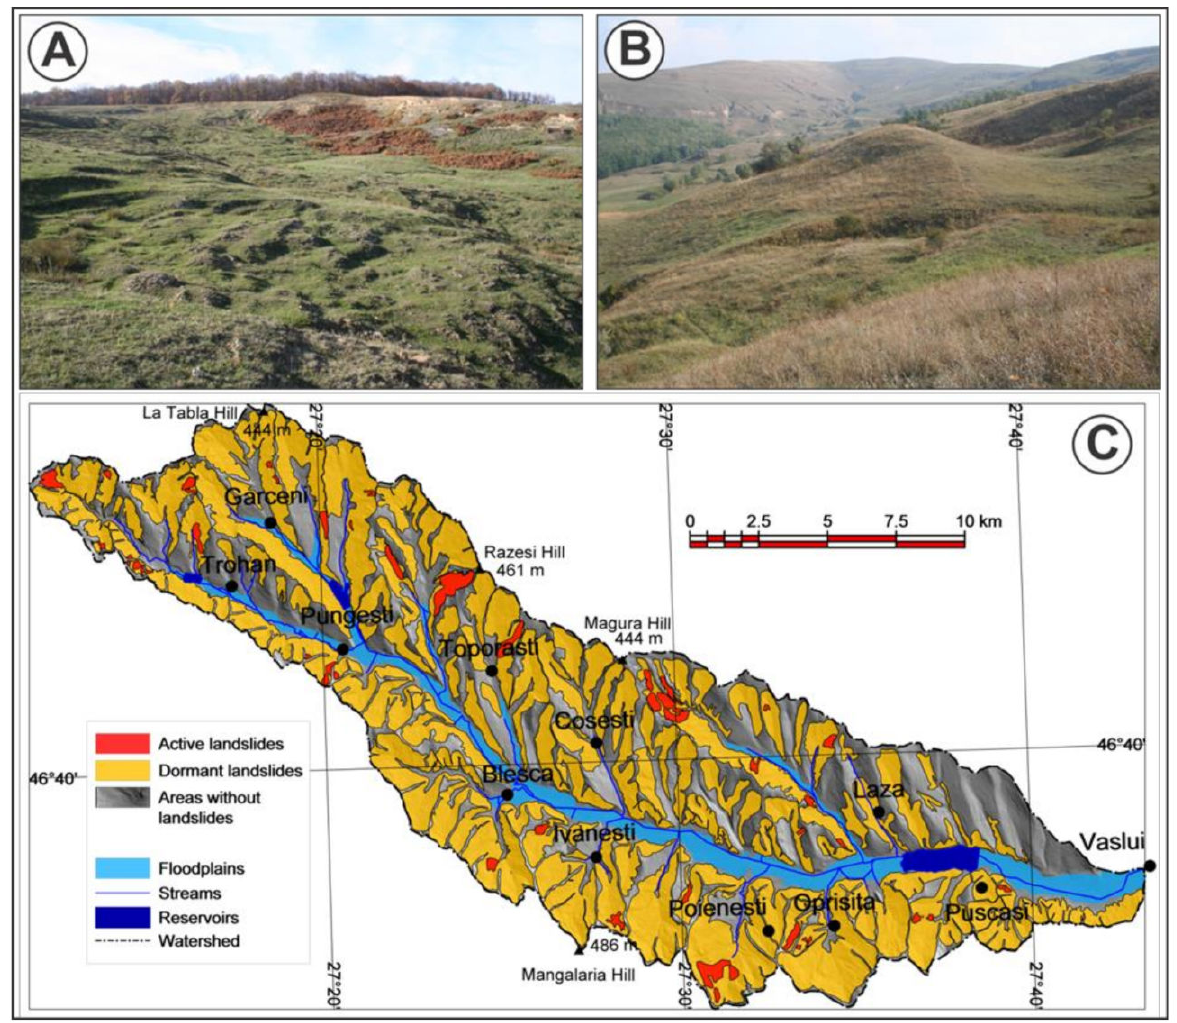
Figure 5. Reactivation of old landslides after deforestation in the upper catchment of the Racova upstream of Slobozia on 20 October 2013 ( A ), ample Canepa landslide amphitheatre (hartop), underlain mainly by Maeotian layers in the second step of the Racova cuesta front on 20 October 2013 ( B ), and landslide inventory map from the Racova Catchment, Moldavian Plateau, Romania ( C